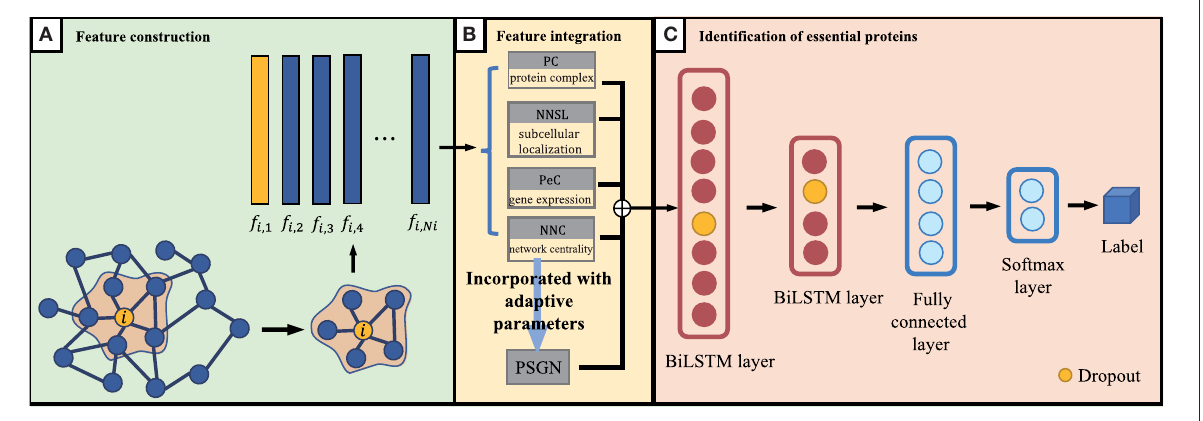
FIGURE3 An overview of our proposed BiLSTM model. (A) Feature construction, (B) Feature integration, and (C) Identification of essential proteins.